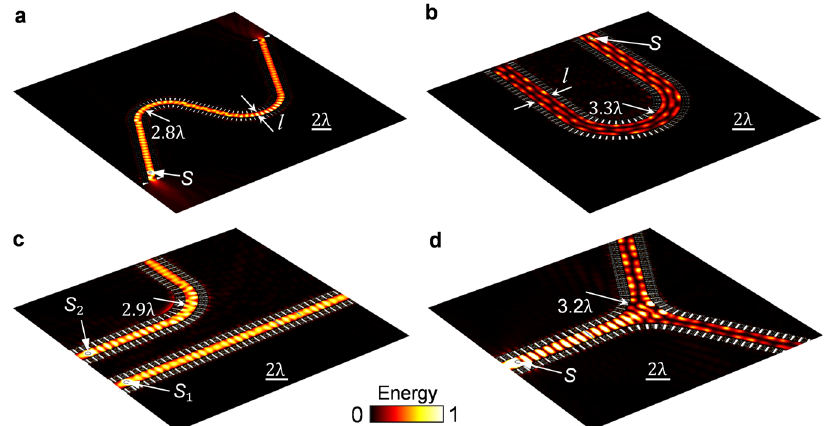
Fig. 4 The proposed waveguide strategy for arbitrary routes at 15 kHz. a Simulated energy fi elds of a “ N ” -shaped waveguide with width l = 0.82 λ . The radius of curvature is 2.8 λ . S refers to the location of point source. b “ U ” -shaped waveguide with width l = 1.47 λ . The radius of curvature is 3.3 λ . S refers to the location of point source. c Two adjacent waveguide paths with a distance of 2 λ ( l = 0.82 λ ). The radius of curvature is 2.9 λ . Two point sources are placed on S 1 and S 2 . d Wave splitting by a waveguide junction ( l = λ ). The radius of curvature is 3.2 λ . S refers to the location of point source.